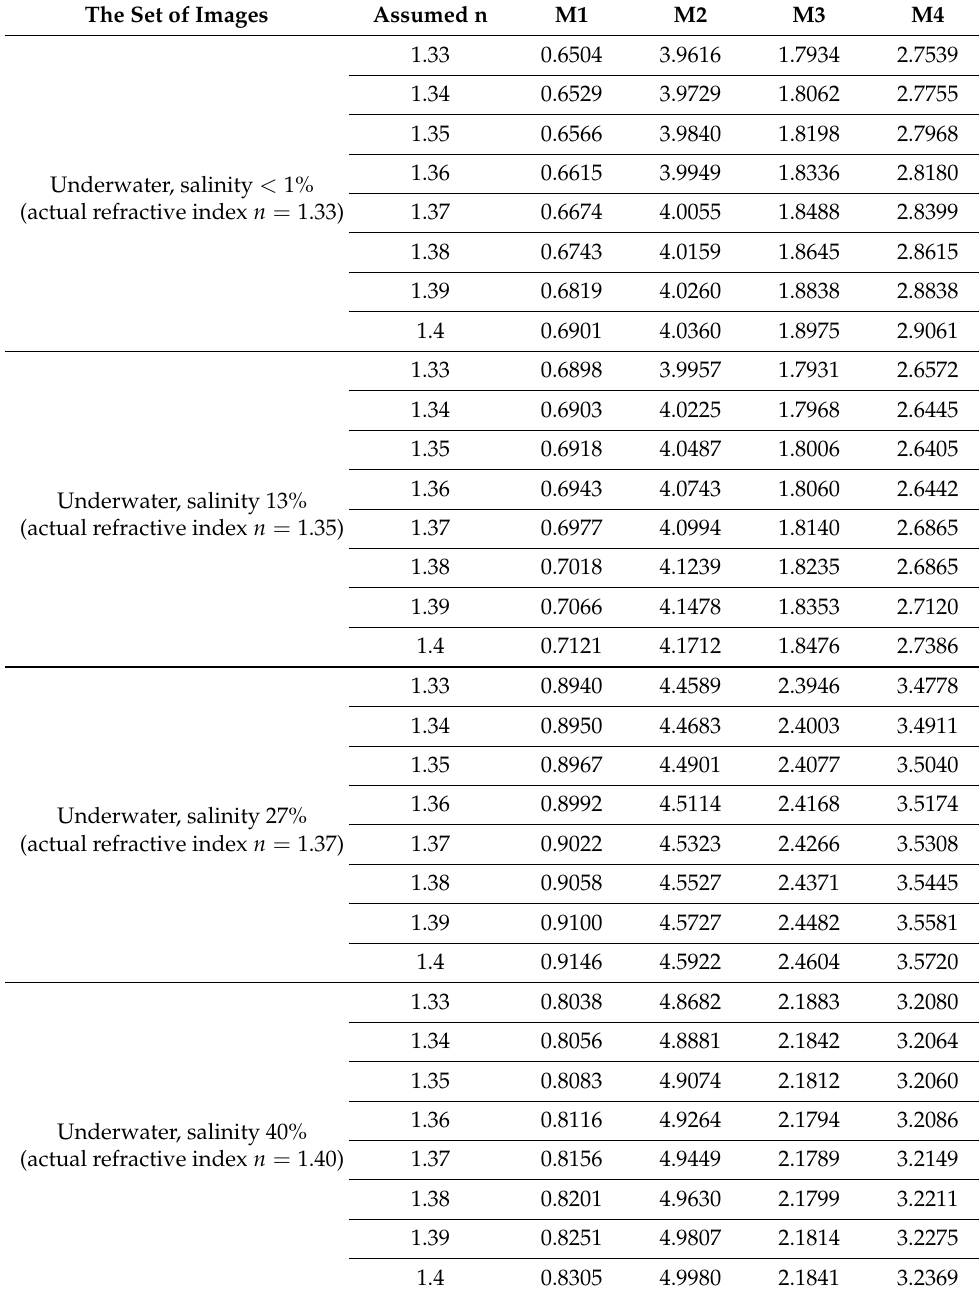
Table 2. Dependence of RD correction error when using Formula (2) on the accuracy of specifying the water refraction index. The Set of Images Assumed n M1 M2 M3 M4